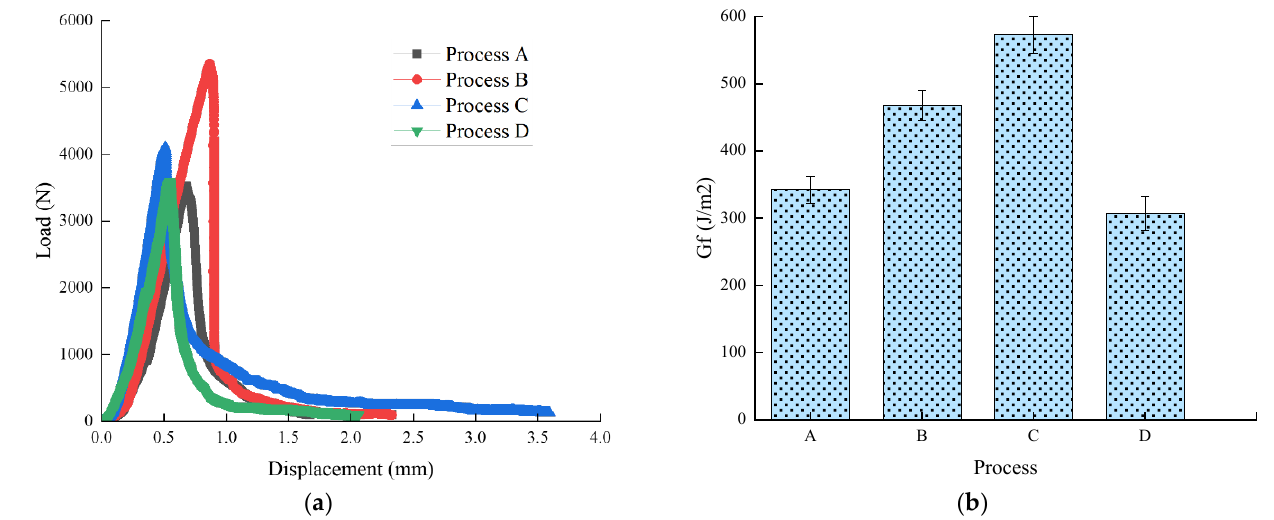
Figure 10. Results of SCB test: ( a ) load–displacement curves; ( b ) fiber mixing processes and fracture energy.